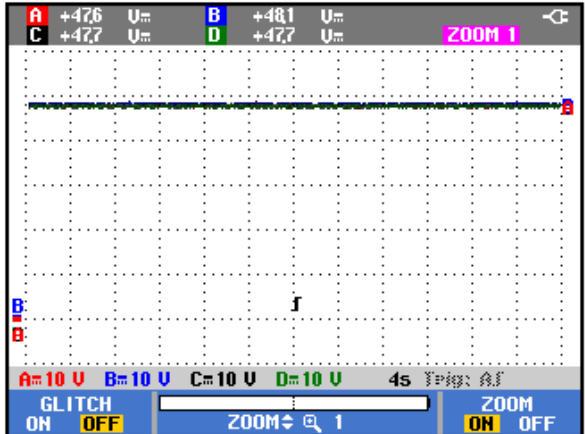
Figure 16. DGU voltages during sequential voltage attacks.